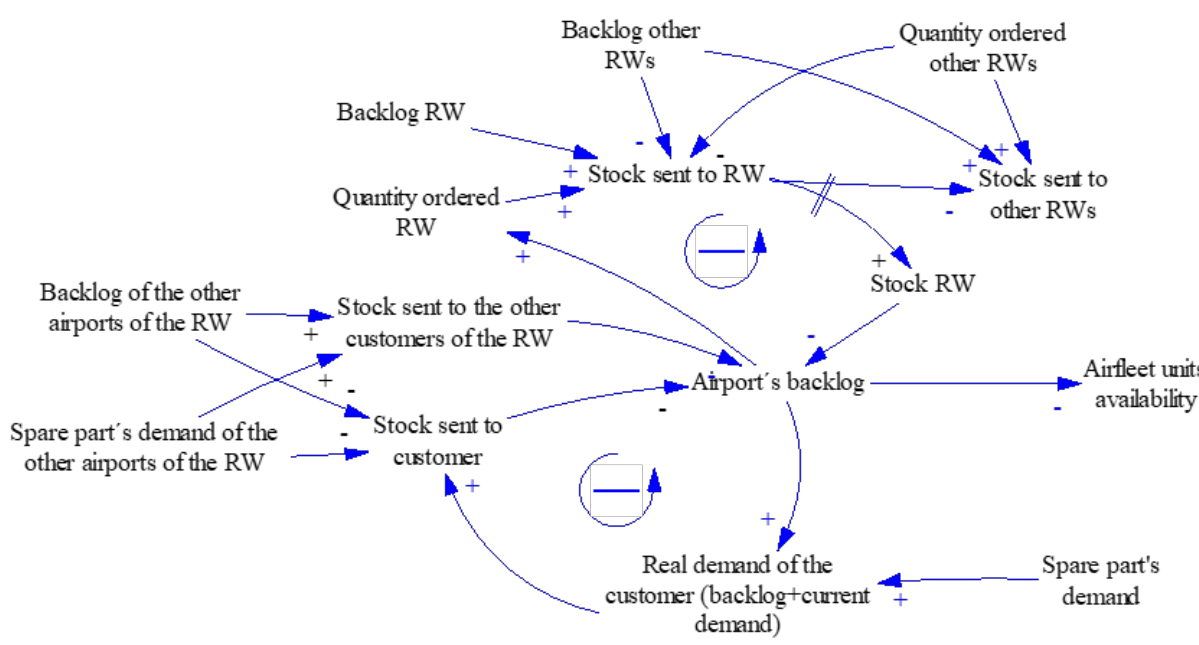
Figure 5. CLD for shipments coordination (own elaboration).